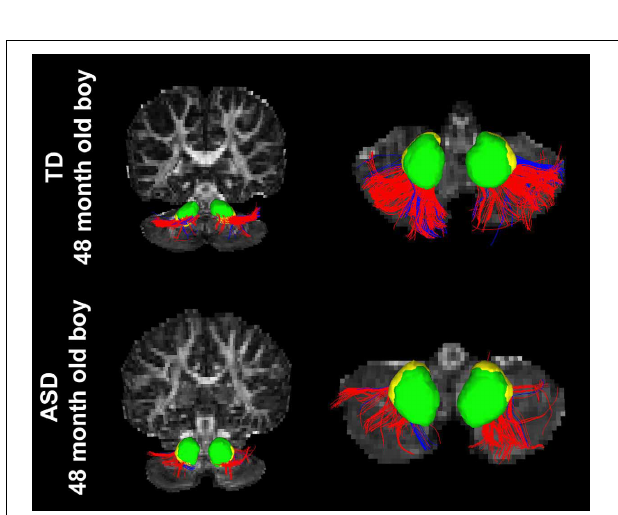
FIGURE 2 | Estimated head motion index (sum of displacements) obtained from individual children in the TD and the ASD groups. For each child, a , b = 0 image was selected as a target image for co-registering the 55 b = 1000 images. Six motion parameters including three translation and three rotation parameters in x,y,z were estimated for each b = 1000 image. For each parameter, the absolute displacement between adjacent images was averaged to assess the degree of head motion (Ling et al., 2012). The summation of the six motion assessments was used to denote overall degree of head motion for each child. Note that this index has no unit since two physical metrics (mm and radian) are summed.